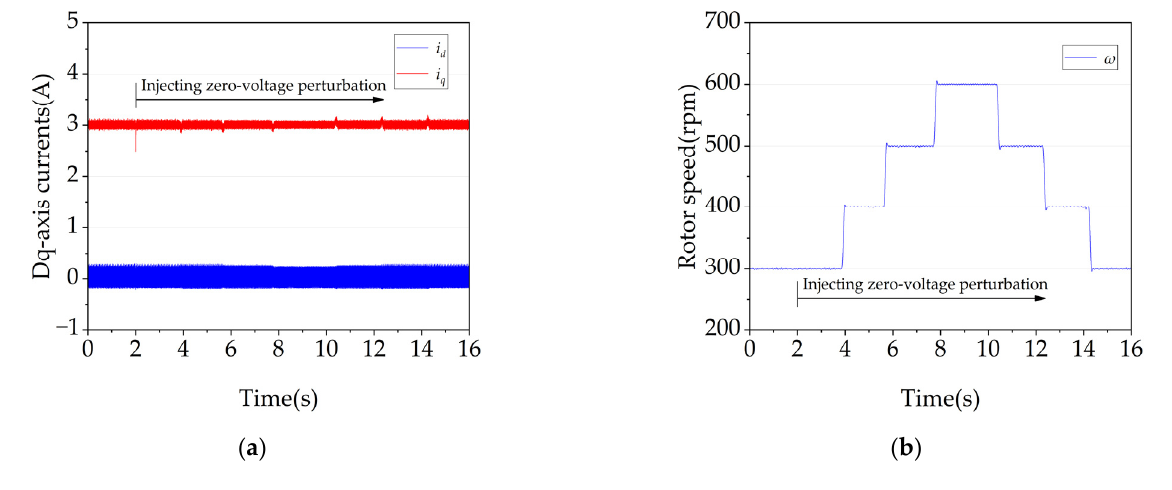
Figure 5. PMSM waveforms under variable speed control ( i d = 0, i q = 3 A). ( a ) Dq − axis currents; ( b ) rotor speed.